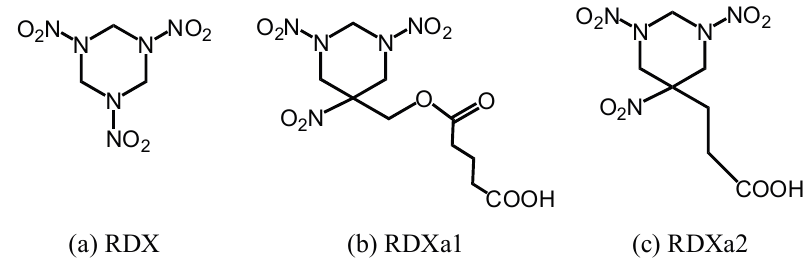
Figure 7. Structural formulae of ( a ) RDX, ( b ) RDXa1, and ( c )